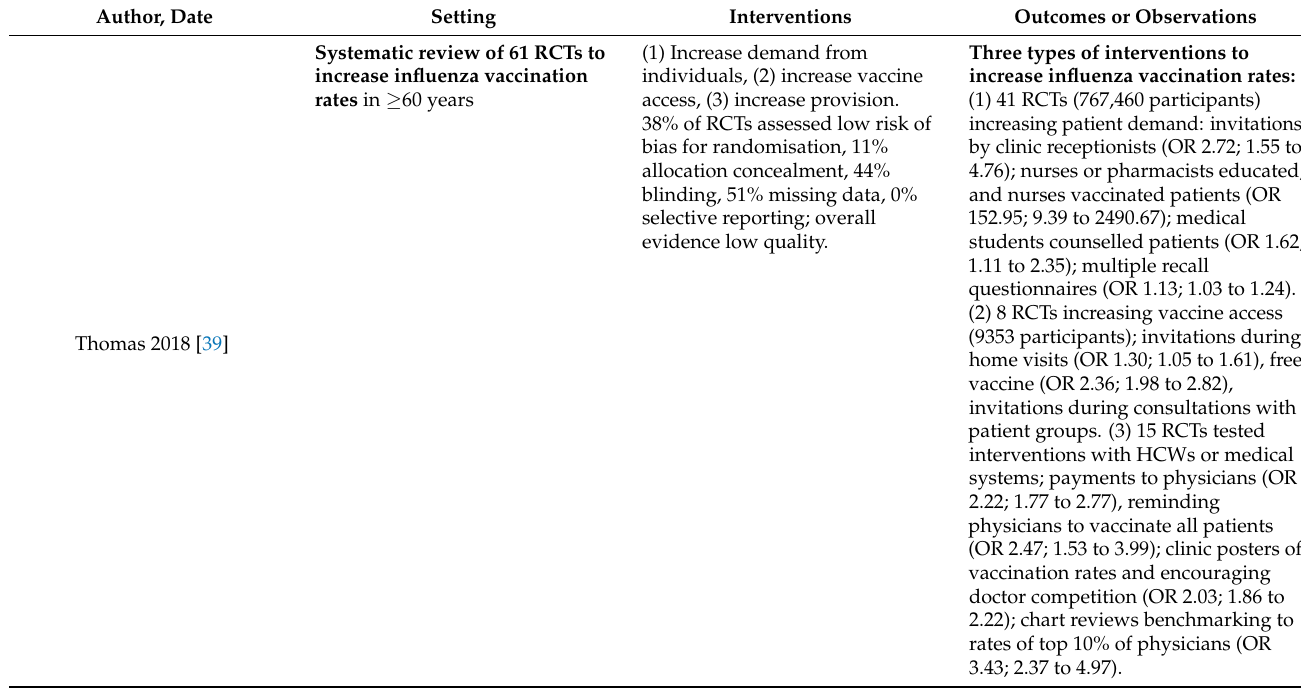
Table 5. Interventions to increase influenza and pneumococcal vaccination rates in seniors and in HCWs. Author,